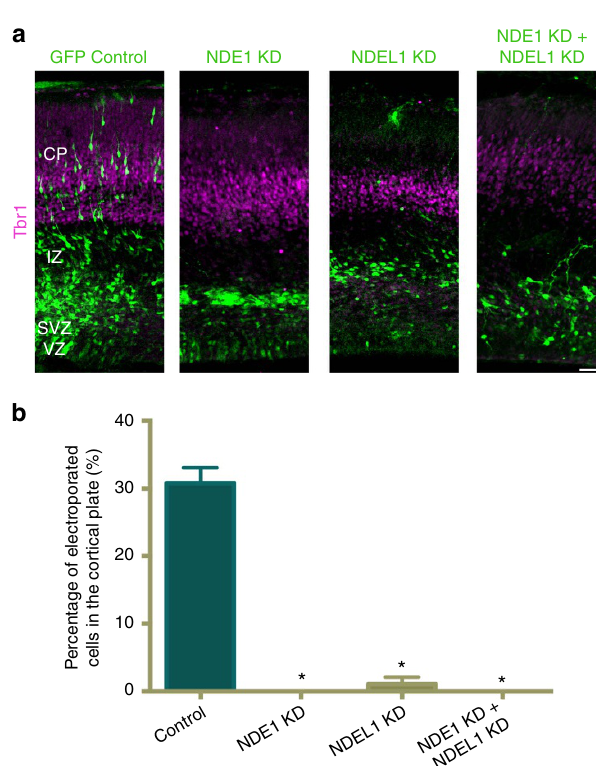
Figure 1 | Effects of NDE1 and NDEL1 RNAi on neuronal migration into the cortical plate. ( a ) Representative images of embryonic day 20 (E20) rat neocortex with a control vector expressing GFP alone, or shRNAs to NDE1, NDEL1, or both genes along with a GFP reporter. Sections were stained for Tbr1 to mark neurons in the cortical plate (CP). Scale bar, 50 m m. ( b ) Quantification of the fraction of electroporated cells in the CP across NDE1, NDEL1 or combined RNAi conditions 4 days post electroporation at E16. All knockdown conditions nearly eliminated any cells from reaching the CP, in comparison with control neurons. Data are presented as mean ± s.e.m., unpaired t-tests used for all comparisons. * P o 0.05, n ¼ 3 embryonic brains from different